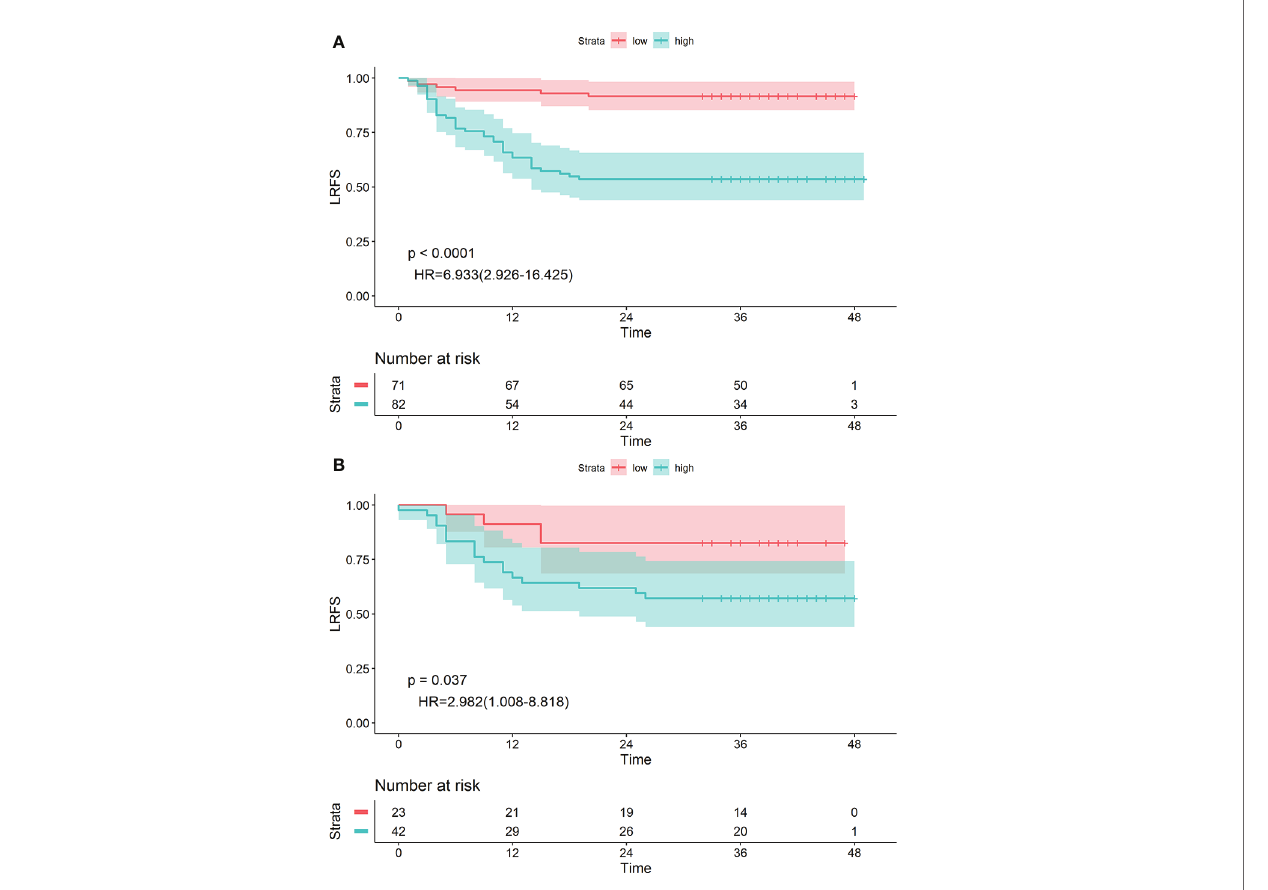
FIGURE 4 | Kaplan-Meier survival analyses of high-risk and low-risk groups divided by radiological label in the training cohort (A) and validation cohort (B)